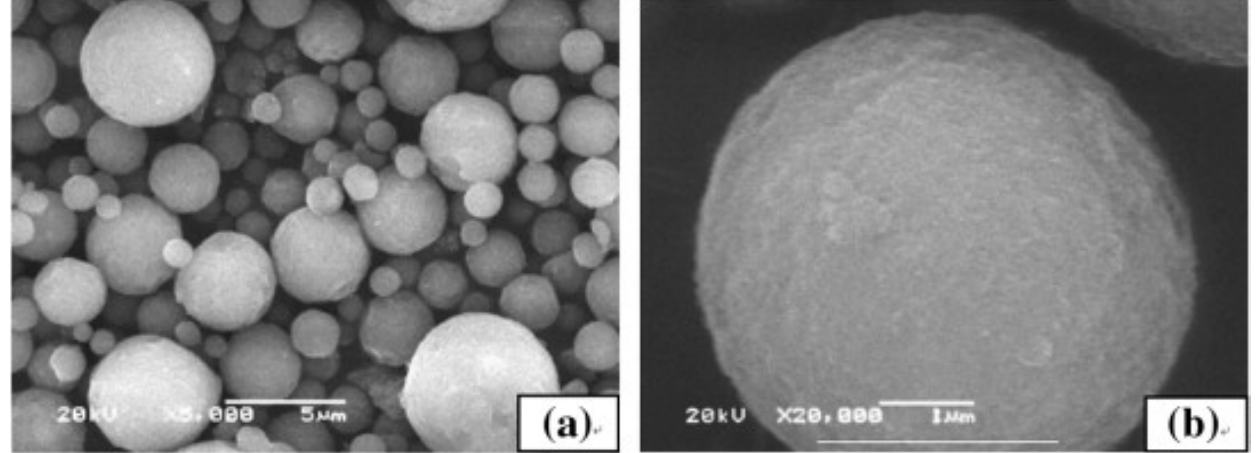
Figure 24. SEM micrographs of hydroxyapatite microspheres fabricated by spray drying: ( a ) overall morphology, ( b ) high magnification surface morphology. Reprinted with permission from [231]. Copyright 2009 Elsevier.